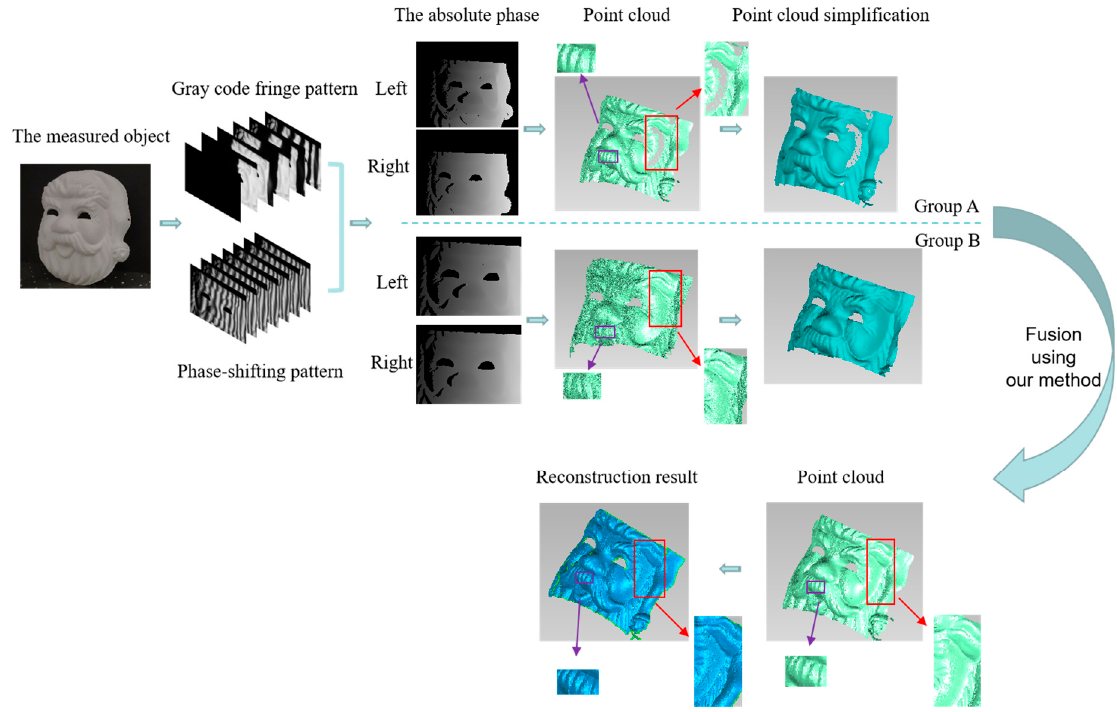
Figure 9. Algorithm flow chart with the Santa Clause mask as an example.